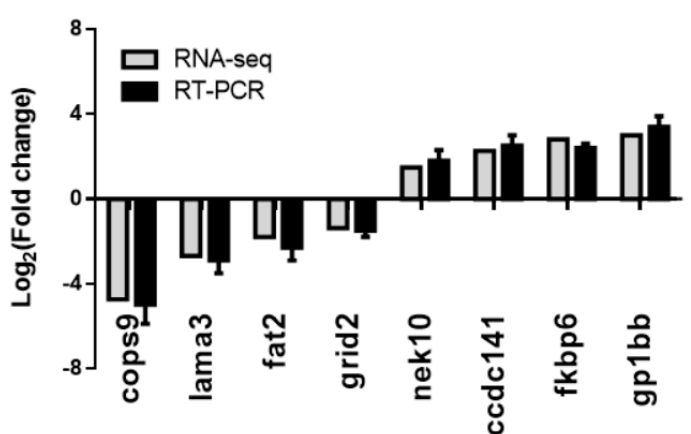
Figure 7. Validation of the RNA-seq results using RT-qPCR methods. The gray columns indicate the RNA-seq results; the black columns indicate the real-time PCR results. The x -axis indicates the gene names; the y- axis represents the value of log 2 (fold change) of the noise exposure group compared with the control group.